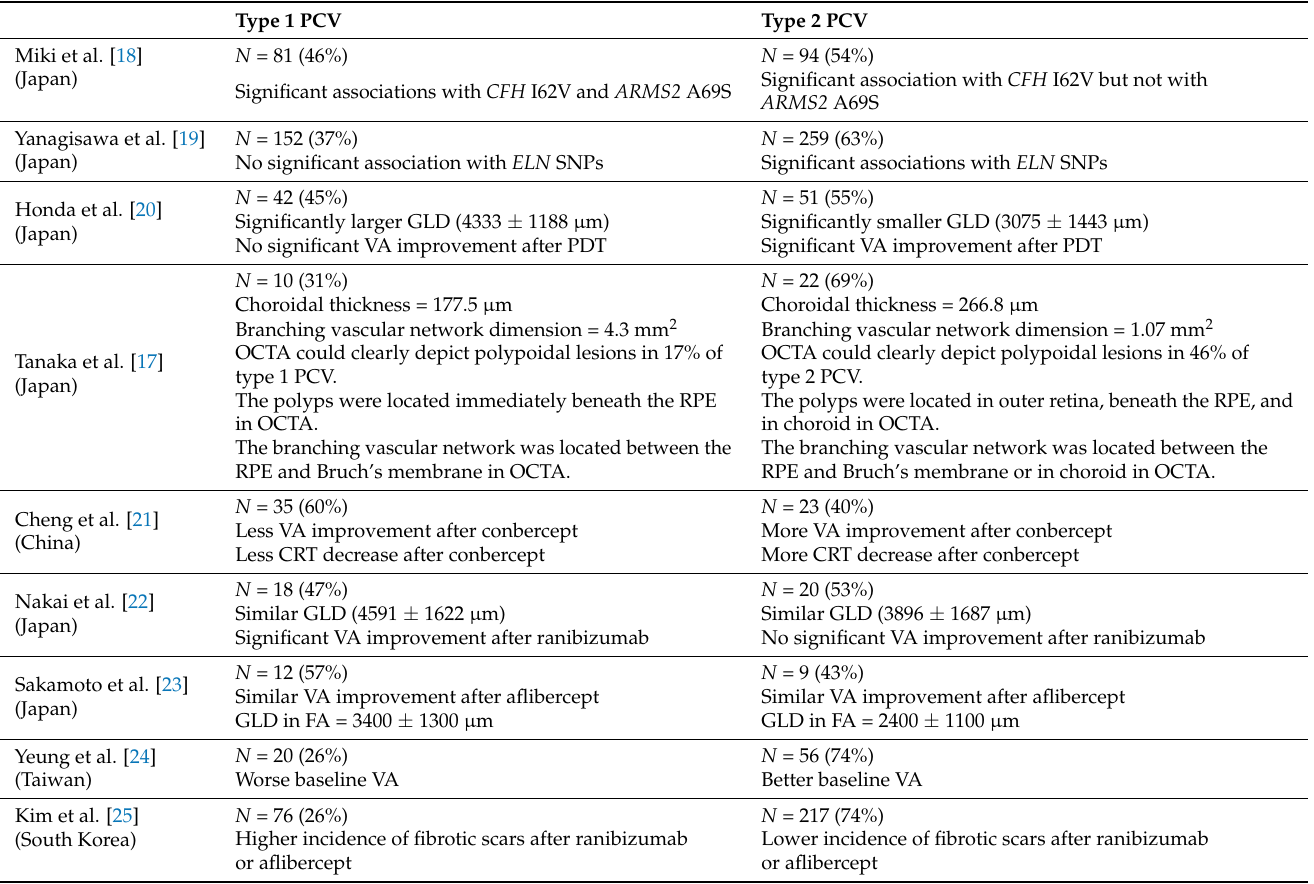
Table 2. Characteristics of type 1 PCV and type 2